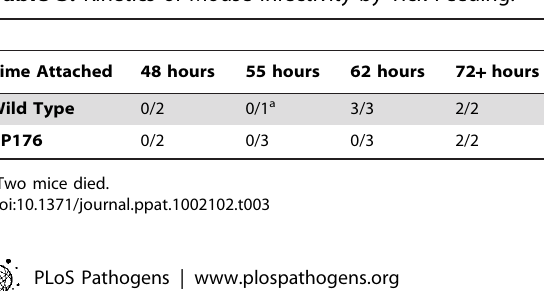
Figure 11. Replication of B31-A3 or CP176 in feeding nymphs. B31-A3- or CP176- infected nymphs were placed on naı¨ve mice, removed at the indicated times and spirochete density was determined by qPCR. significantly different from each other ( P , .05) at all time points except 48 hours. Error bars indicate SEM.